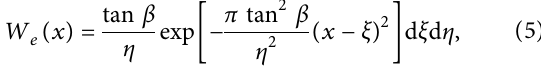
Figure 3: Calculation model for single and twin tunnels before and after convergence. (a) Model for single tunnel. (b) Model for twin tunnels (modified after Yang’s solution